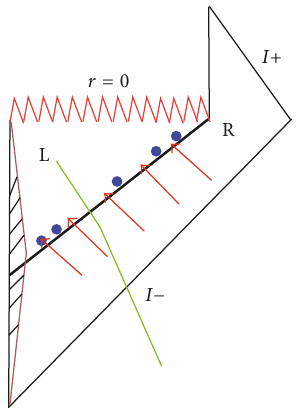
Figure 1: Penrose diagram depicting the matching between the randomly embedded qubits (blue dots) and strong fluctuations (red arrows). The wave-like red line is the singularity (𝑟 = 0) , the solid black line is the global horizon (𝑟 = 2𝑀) , and the green line is the worldline of an infalling observer. 𝐿 and 𝑅 stand for left and right Rindler wedge, respectively. L − and L + denote past and future null infinity,